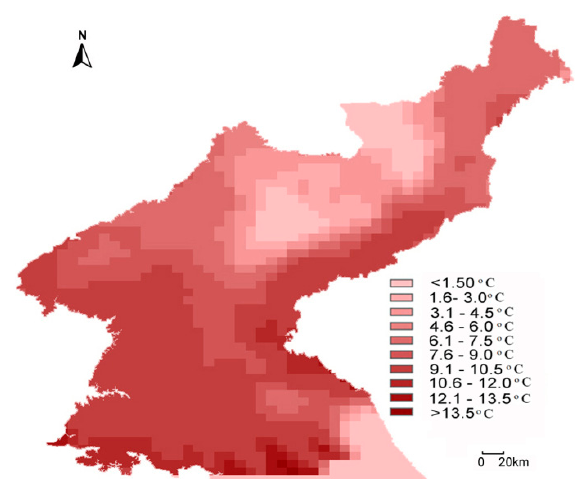
Figure 5. Spatial distribution of average annual temperature evaluated over the 1961–2010 period (cell size: 10.0 km × 7.1 km). Table 2. The contribution rates for components